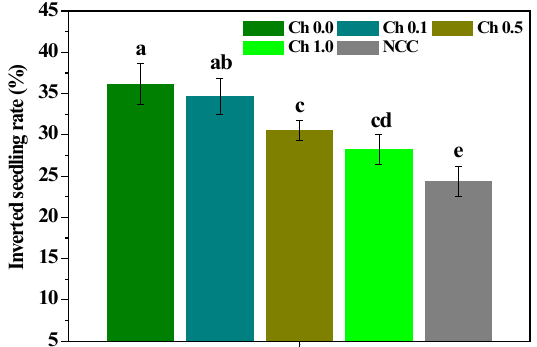
Figure 1. The influence of chitosan spraying on the inverted seedling rate of P. ternata . Error bars show SD, and different letters indicate significant differences at 5% ( p < 0.05) level. 2.2. Influences of Chitosan on Photosynthetic Capacity of P. ternata